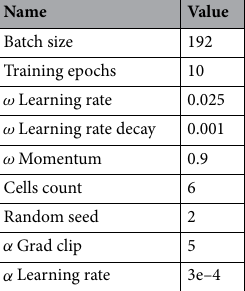
Table 6. Hyperparameters setting for optimal CNN